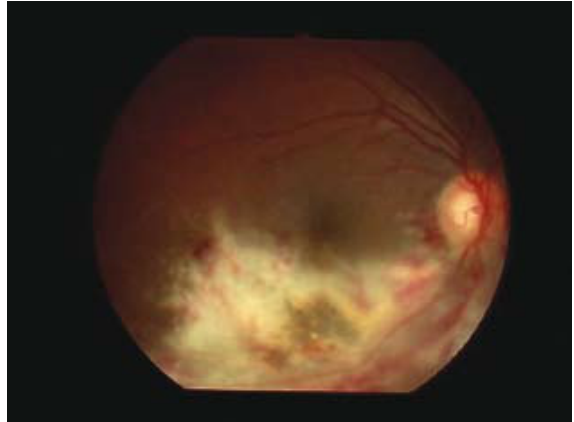
Fig. 1. CMV Retinitis at baseline. Full-thickness retinal necrosis along the inferotemporal arcade with some haemorrhage. There is minimal vitritis and mild macular oedema (courtesy Dr Linda Visser, University of KwaZulu-